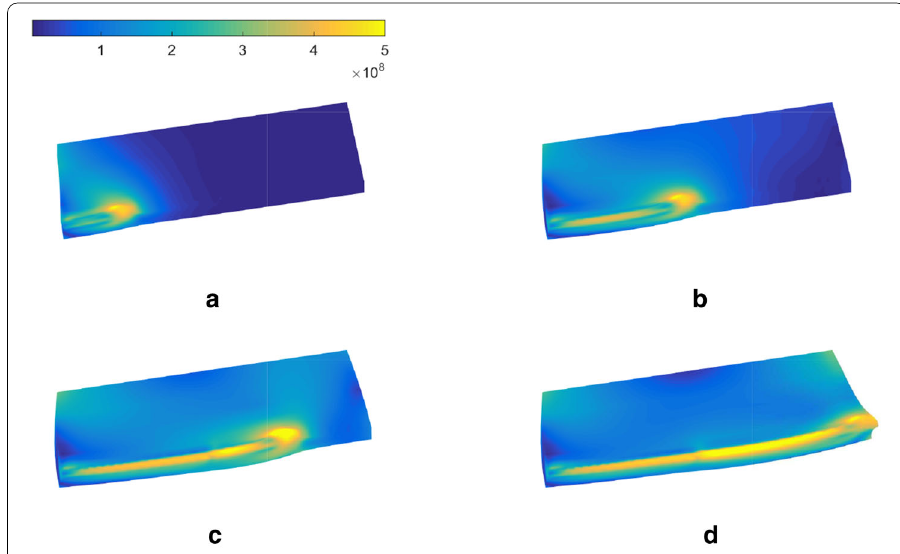
(cid:10) (cid:11) × 10 6 W . m − 2 . a t = 47 . 5 s . b